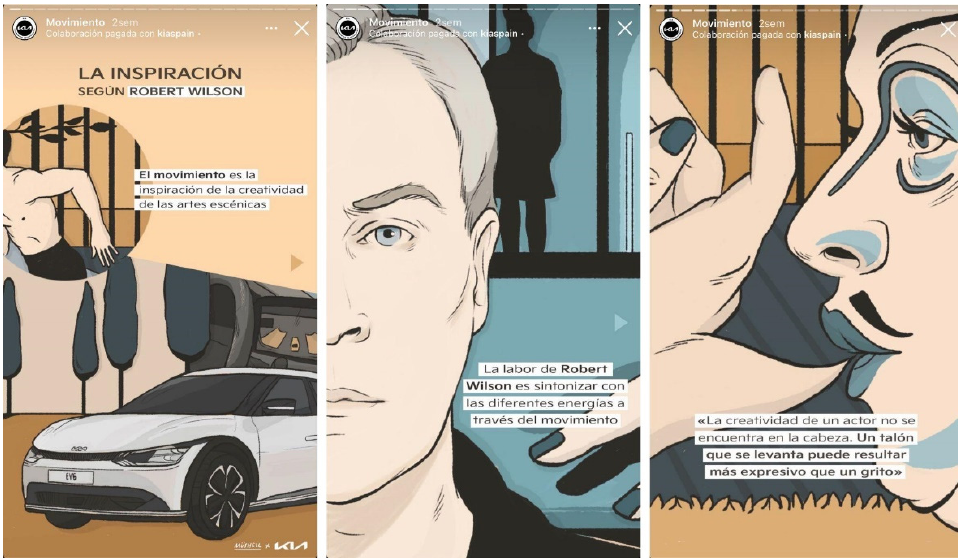
Figure 4. Native advertising action by Yorokobu magazine through its stories for KIA Spain: play- wright Robert Wilson’s reflections on inspiration and movement.